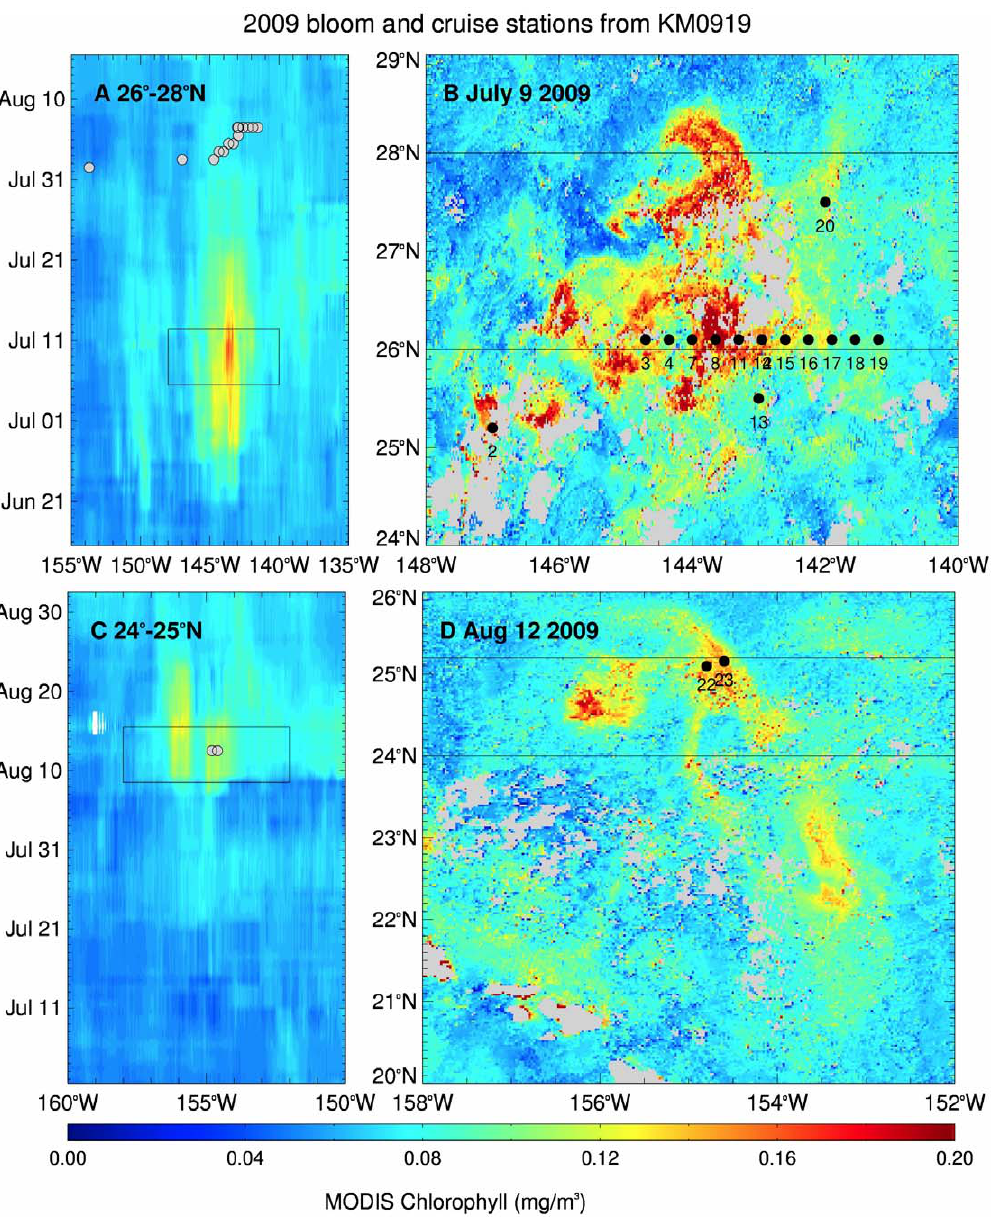
Figure 5. Satellite chlorophyll a estimate with overlying stations for 2009. (a) Hovmo¨ller diagram of MODIS chl showing the development of the 2009 bloom at 140 u W and (b) an 8-day composite showing the maximum extent of the chlorophyll bloom at 140 u W, overlaid with station locations. (c) Hovmo¨ller diagram of MODIS chl showing the development of the 2009 bloom at 155 u W and (d) an 8-day composite showing the maximum extent of the chlorophyll bloom at 155 u W, overlaid with station locations. The black lines on (a) and (c) depict the temporal and longitudinal extent of the data shown in (b) and (d), and the black lines on (b) and (d) depict the latitude range of the data shown in (a) and (b).